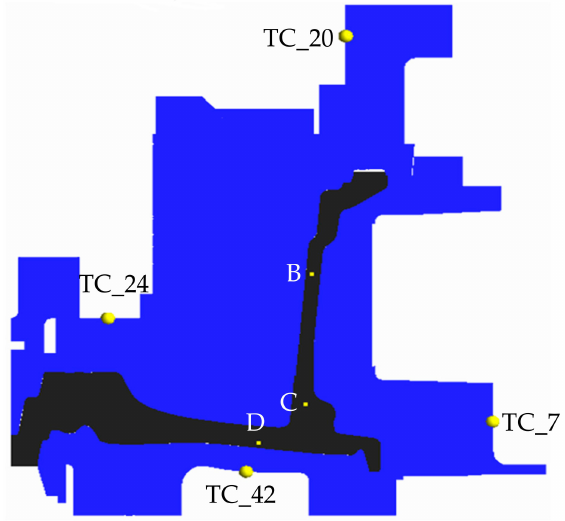
Figure 2. Thermocouple locations in the wheel and die cross-section, cutting plane through wheel